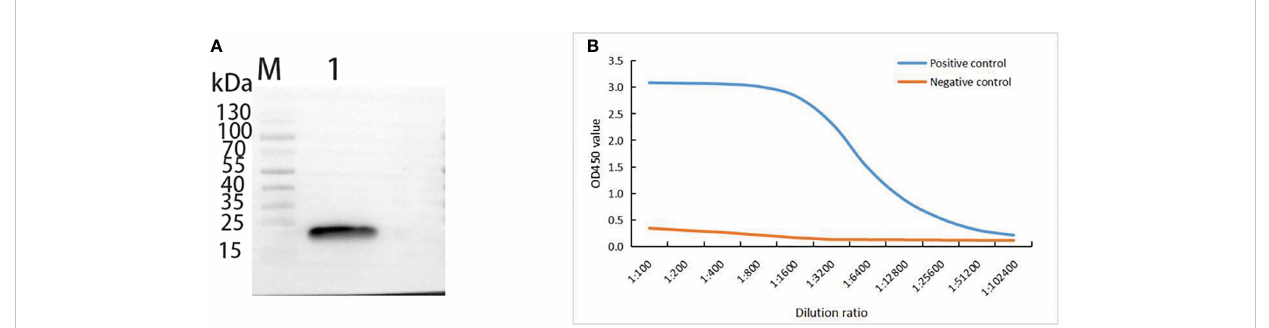
FIGURE 2 Immunogenicity analysis of mouse anti-Lrp polyclonal antibody. (A) Western-Blotting to detect the speci fi city of polyclonal antibodies. M: protein Marker; 1: Lrp recombinant protein (B) ELISA to detect the titer of polyclonal antibodies; Positive control: using mouse anti-Lrp serum as primary antibody; Negative control: using mouse PBS-injected serum as primary antibody.